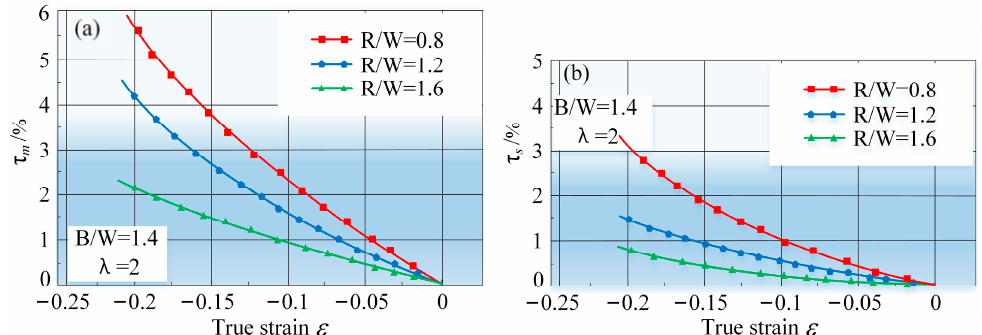
Figure 7. Effect of fillet radius R on ( a ) τ m and ( b ) τ s .